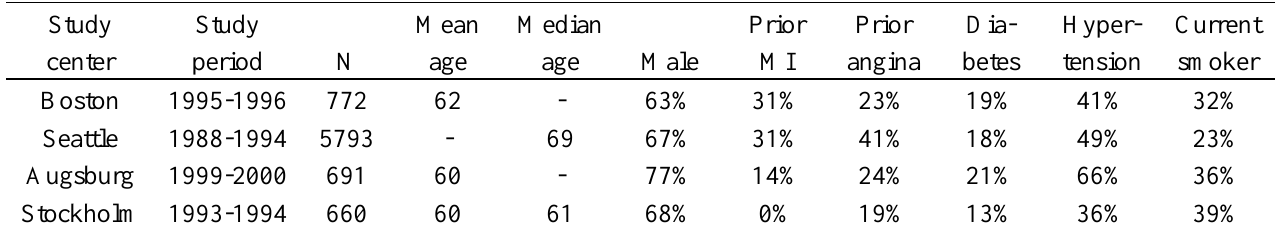
Table 4. Characteristics of myocardial infarction cases: a comparison of four studies. Study